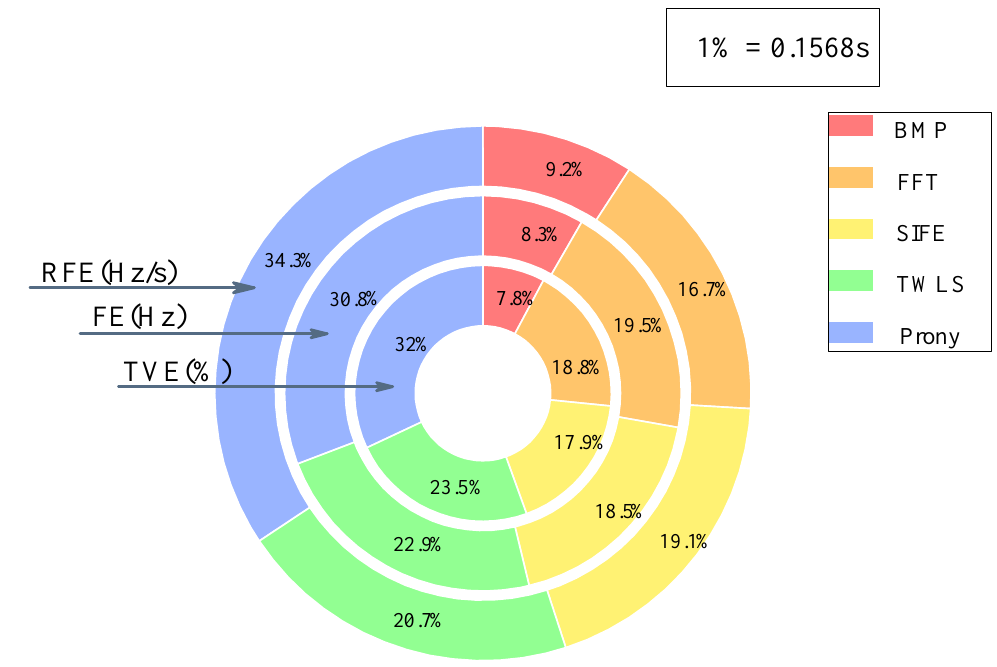
Figure 3. Runtime ratio of each method under the step.